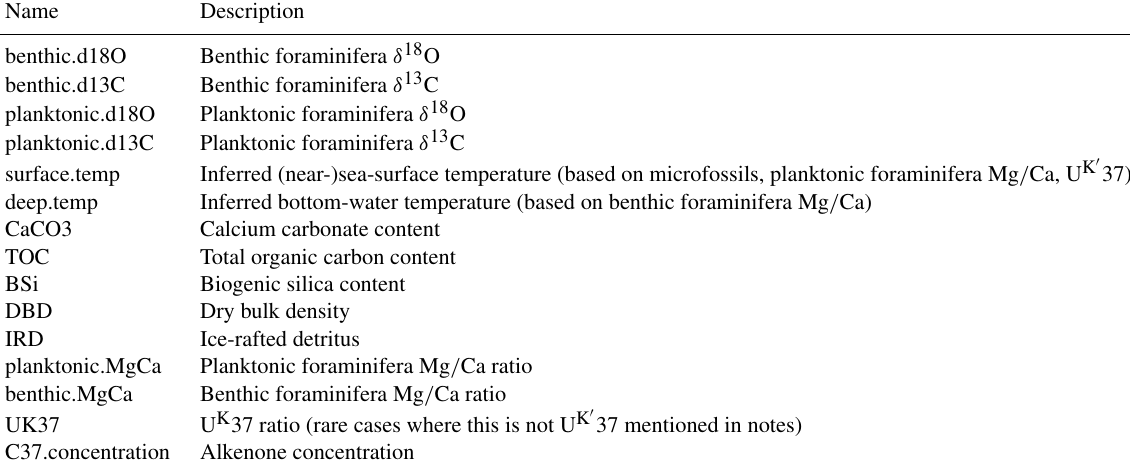
Table 3. Standardised parameter names. Name Description benthic.d18O Benthic foraminifera δ 18 O benthic.d13C Benthic foraminifera δ 13 C planktonic.d18O Planktonic foraminifera δ 18 O planktonic.d13C Planktonic foraminifera δ 13 C surface.temp deep.temp CaCO3